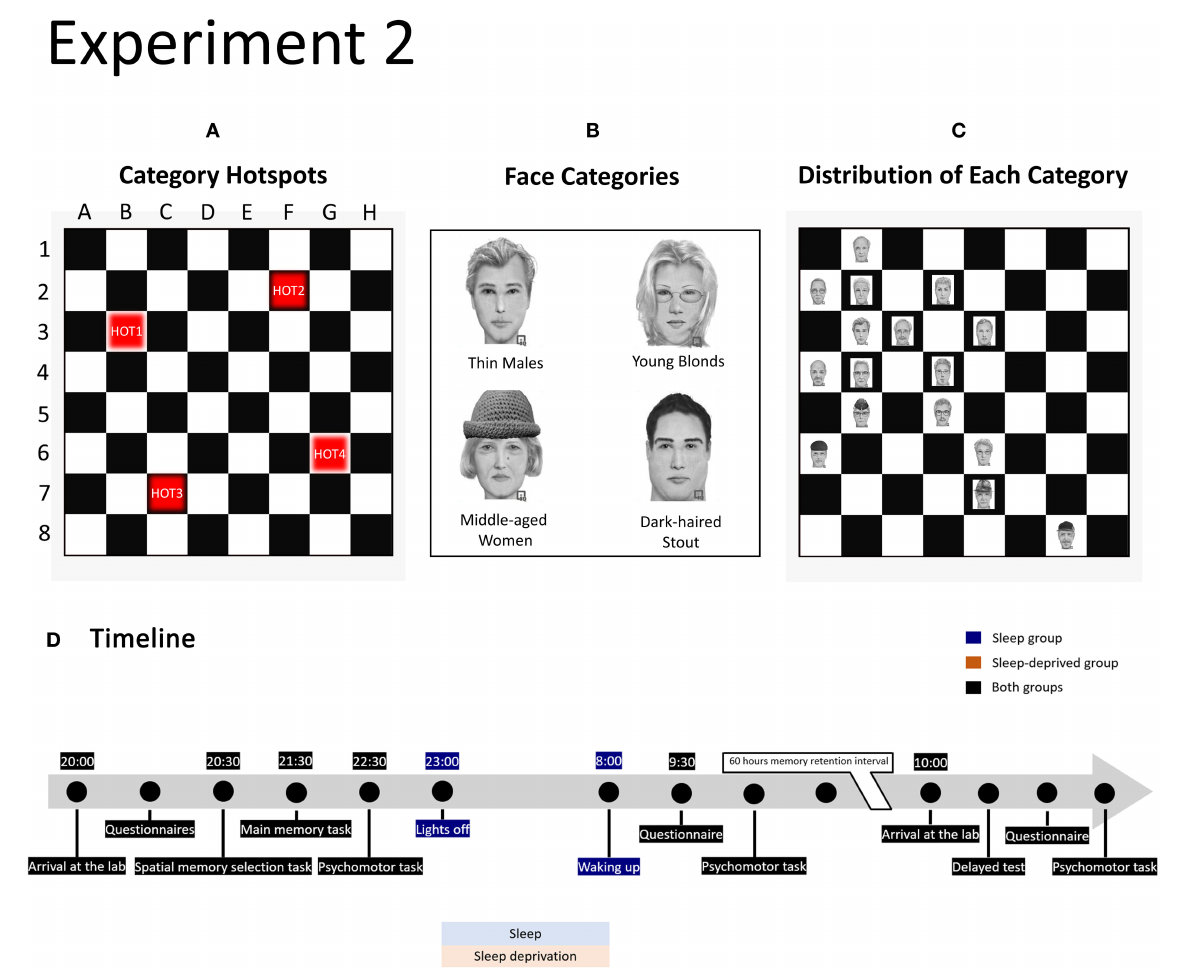
FIGURE2 Design of experiment 2. (A) Position of category hotspots on the memory board. (B) Example for each of the four face categories. Each category holds 16 different faces featuring a combination of two features that is unique to that category. The four face categories are each coupled to a category hotspot (coupling was randomised across participants). (C) Example of the distribution of faces in one category (here Thin Males) around hotspot 1. The hotspot location always features a correct category face. For locations, one square removed from the hotspot, 5 of the 8 squares hold correct category faces (62.5%) and 3 squares hold other face categories (37.5%), and so forth. (D) Timeline of the experimental procedure in the sleep and sleep-deprived conditions.